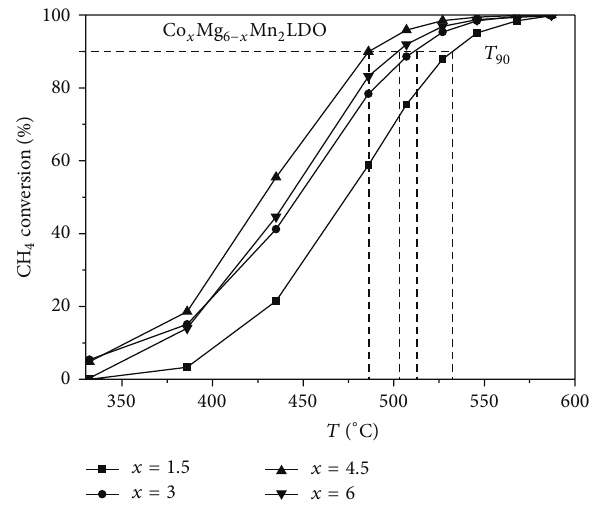
Figure 6: Catalytic activity of Co 𝑥 Mg 6−𝑥 Mn 2 LDO samples (1% vol. CH 4 , 10% vol. O 2 , GHSV = 25000 h −1